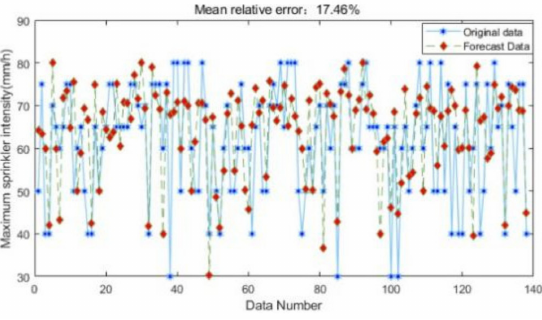
Figure 12. The smoothness parameter of the GRNN is 0.04.